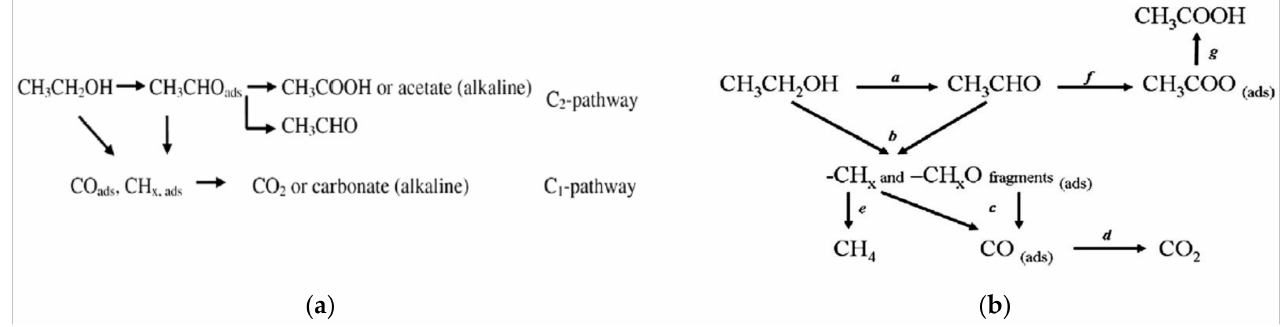
Figure 4. Mechanism of ethanol oxidation in ( a ) alkaline and ( b ) acidic media reprinted with permission of Elsevier